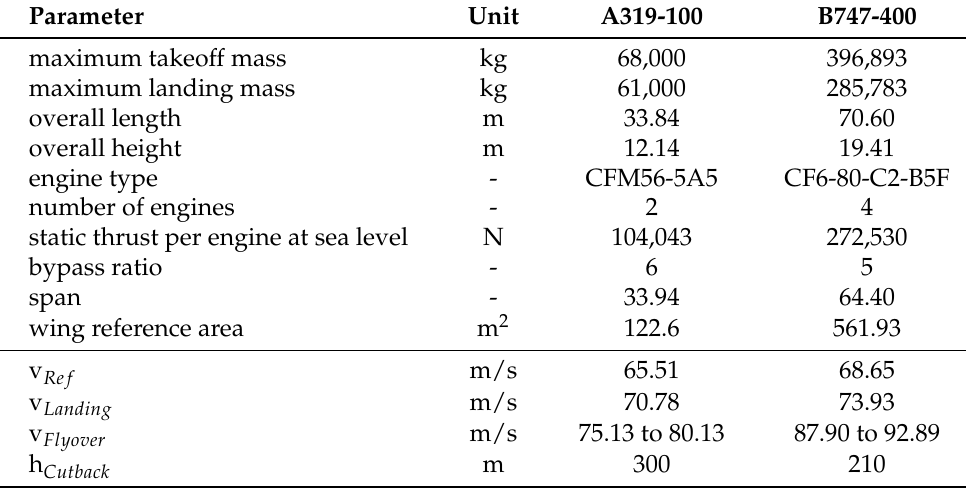
Table 2. Data of two investigated